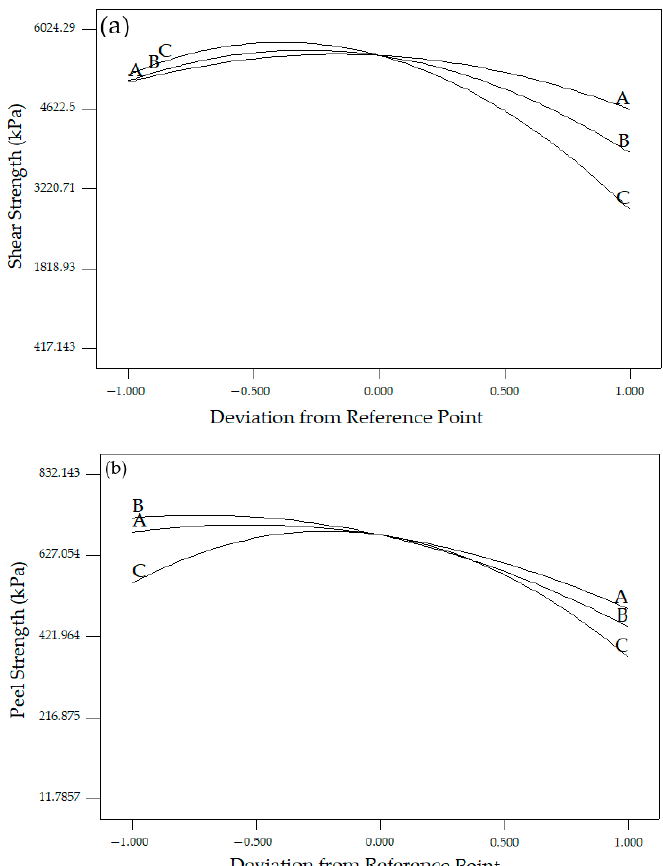
Figure 7. Perturbation plots: ( a ) shear strength and ( b ) peel strength.